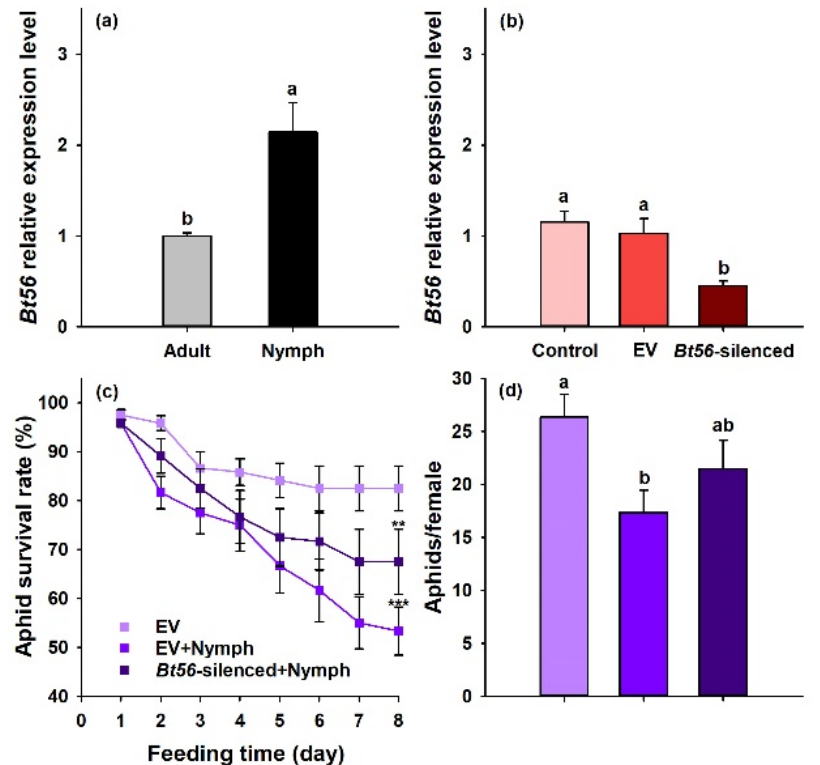
Figure 4. Effect of Bt56 silencing on M. persicae performance. The transcript levels of Bt56 in B. tabaci MEAM1 ( a ). The transcript levels of Bt56 in B. tabaci nymphs feeding on pTRV2- Bt56 tobacco ( b ). M. persicae survival ( c ) and fecundity ( d ) on B. tabaci MEAM1 nymph-infested tobacco plants. Error bars represent standard error of the means. The asterisks above the bars indicate significant differences (** p < 0.05, *** p < 0.001). The different letters above the bars indicate values that are significantly different ( p < 0.05).